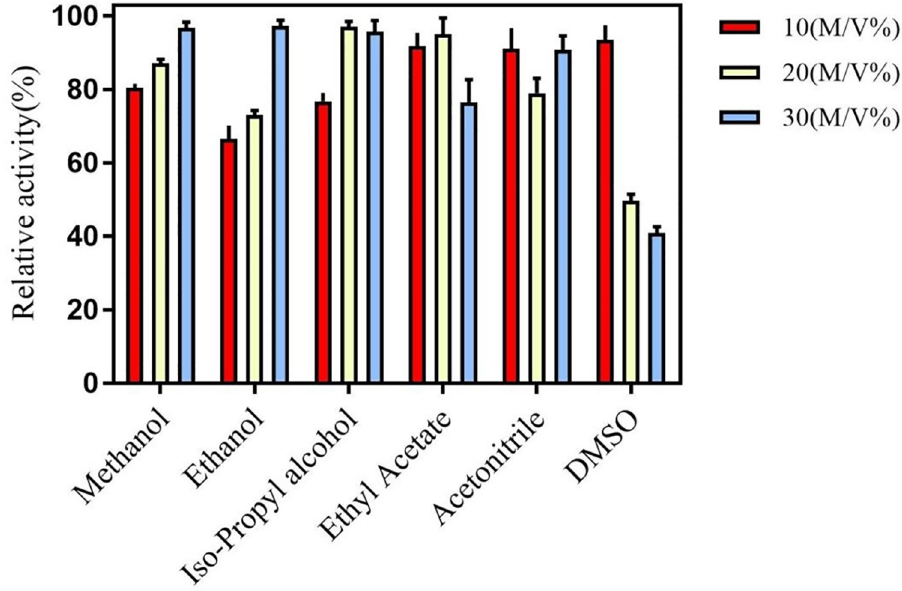
Fig 4. Organic solvent tolerance of the AKR. AKR is sensitive to six different organic solvents (methanol,Ethanol, 2-propanol, ethyl acetate, acetonitrile, and DMSO) with a gradient of 10%(v/v) to 30%(v/v) for each organic solvent. Three parallels were set for each experiment, and the error bar indicated the standard error of the mean